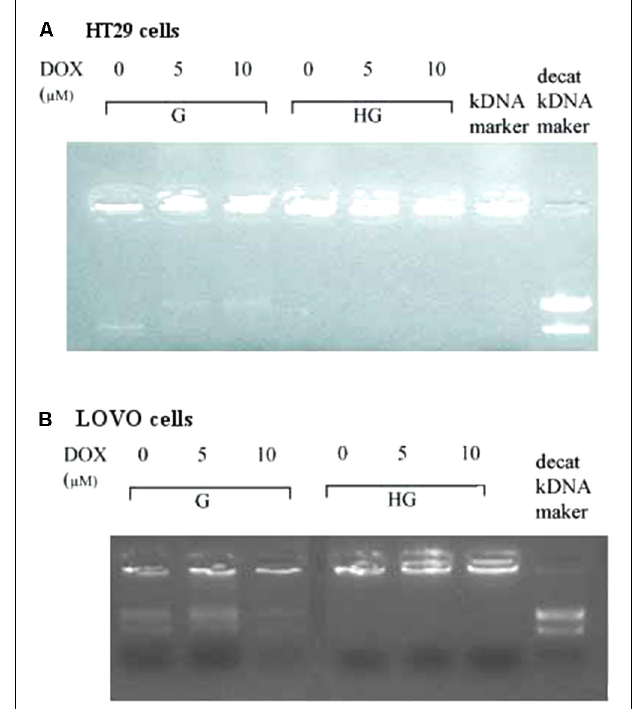
FIGURE 14 | Effect of normal glucose (G) and high glucose (HG) on Topoisomerase II alpha activity in absence or presence of DOX in human colon cancer (HT29 (A) and LOVO (B) ) cells. Cells were cultured for ≥ 7 days in the presence of G and HG, incubated for 24 h before analysis with 5 and 10 µ M DOX, then washed and processed to determine the nuclear Topoisomerase II catalytic activity. The figure is representative of three independent experiments. The nuclear Topo II alpha activity is represented by the reduction of catenated kDNA provided in TopoGEN assay kit and/or the appearance of decatenated